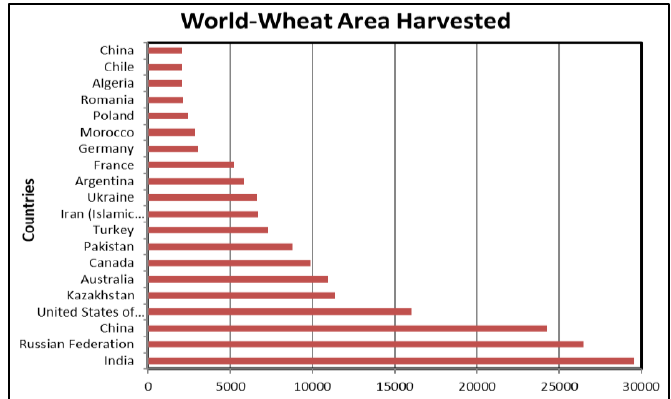
Figure 1: Cultivation areas of top 20 wheat producing countries in 2018. Source: [21].